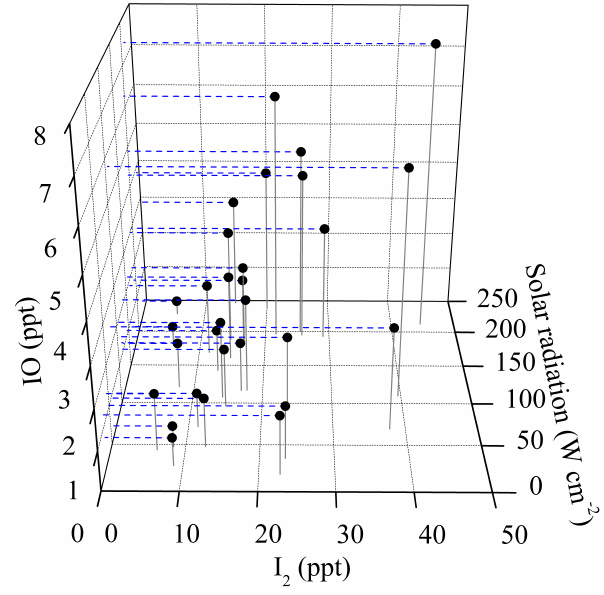
Fig. 5. Observed daytime IO mixing ratios as a function of solar radiation and I 2 . Measurements were taken at Mweenish